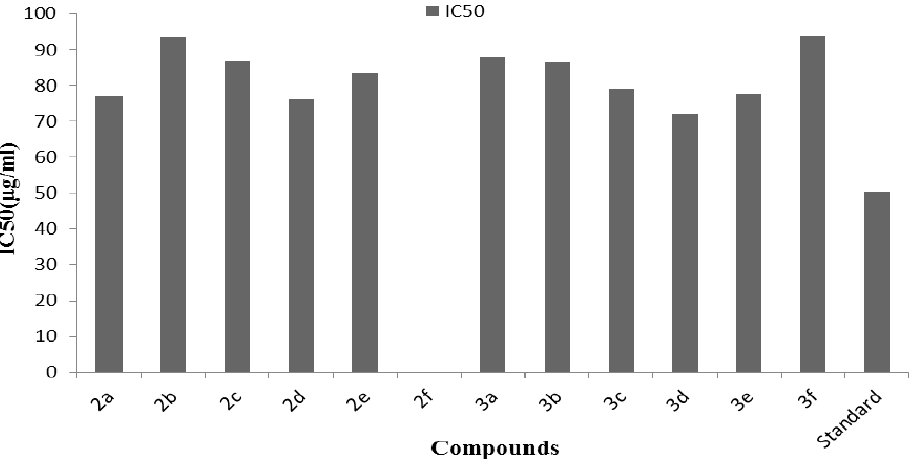
Figure 9. IC 50 values of nitric oxide scavenging activity.